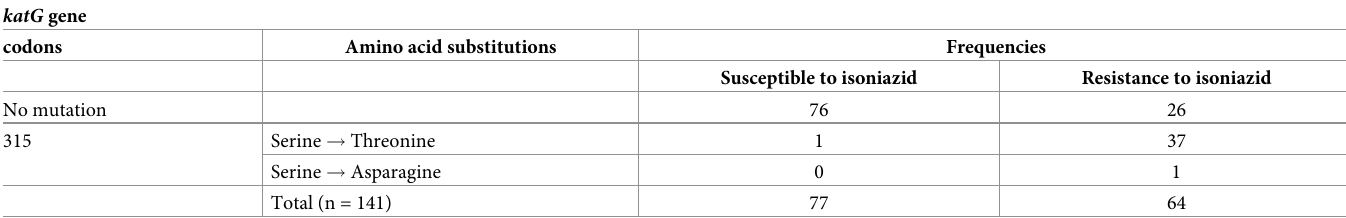
Table 5. Frequency of amino acid substitutions within the katG gene of 141 M . tuberculosis .